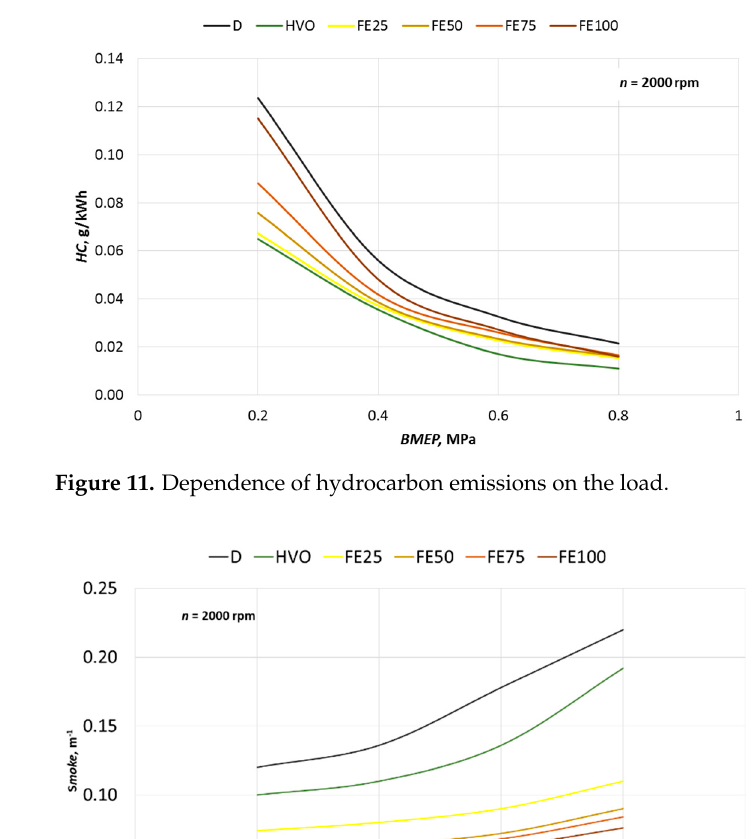
Figure 13. Dependence of nitrogen oxide emissions on the load. At medium load ( BMEP = 0.4 MPa), the nitrogen oxide emissions reduce for FE25~12%, FE50~10%, FE75~10%, FE100~10%, and HVO~20% in comparison with D100. Consequently, a higher combustion chamber temperature results in higher NO x values. Numerous literature review have explained the influence of biodiesel on NO x emis- sions due to the fact that biodiesel contains the oxygen. This improves fuel oxidation in the process of combustion, which has the effect of higher temperature.